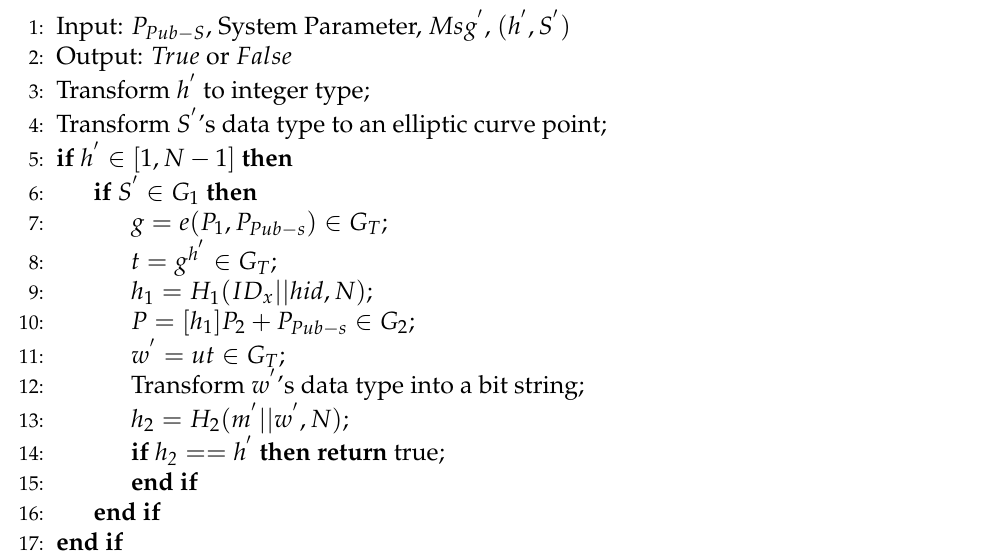
Algorithm 2 Signature verification.